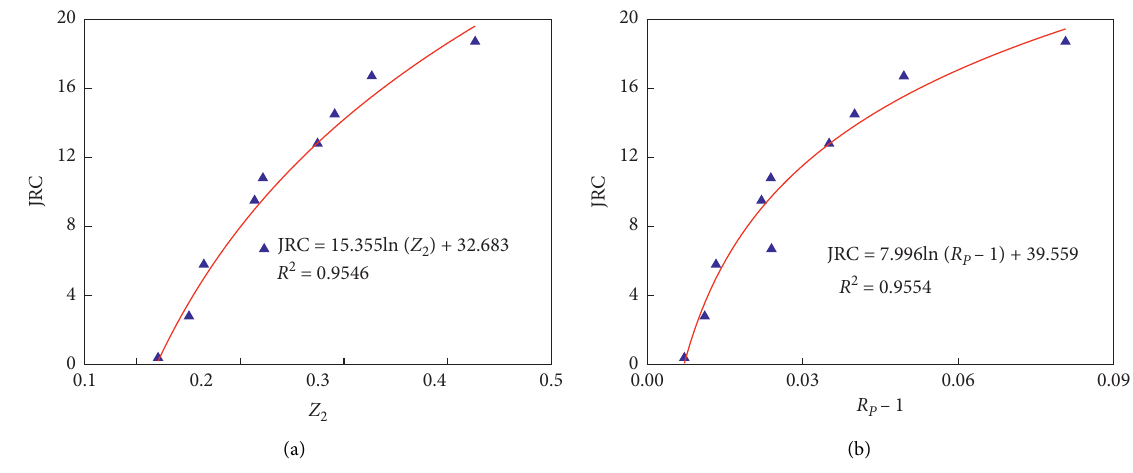
Figure 6: Fitting curves between statistical parameters and JRC. (a) Z